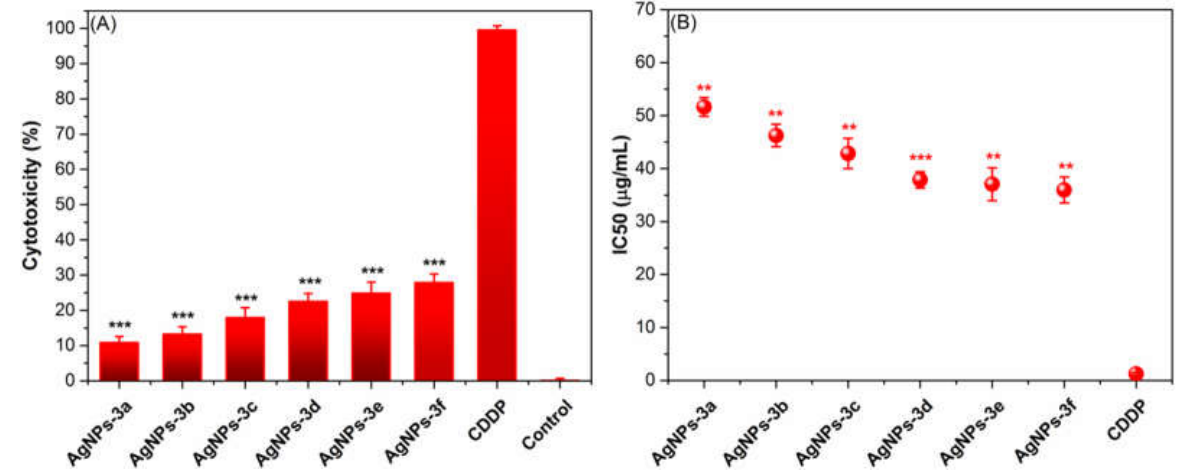
Figure 8. ( A ) A single dose (10 μg/mL) inhibitory impacts of BAIILs-AgNPs on the proliferation of HSF cell lines. ( B ) Values of IC 50 ( μ g/mL) for BAIILs-AgNPs against HSF in comparison to CDDP (**